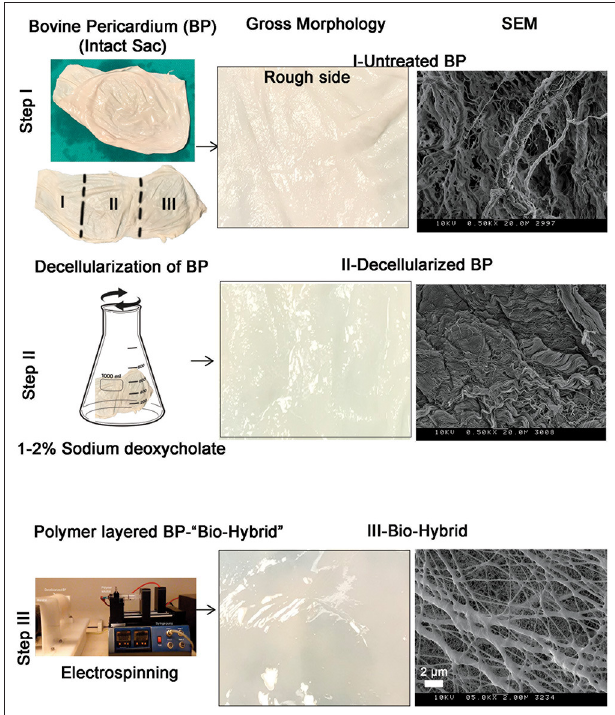
FIGURE 1 | The biohybrid composite fabrication steps by using bovine pericardium (BP). Step I—intact BP is divided into three portions for processing and first portion is left untreated. Right panel shows gross examination and scanning electron microscopy (SEM) image of the untreated BP showing the fibrous side; step II—second portion of the sac is decellularized by using sodium deoxycholate. Right panel shows gross examination of the decellularized BP that shows a blanched appearance due to the detergent and SEM shows the absence of cells on the fibrous side; and step III—coating of polycaprolactone:chitosan polymer layer on the decellularized BP by electrospinning. Right panel shows gross examination of the biohybrid showing a smooth surface after polymer coating and SEM image showing presence of nanofibers on the top surface of